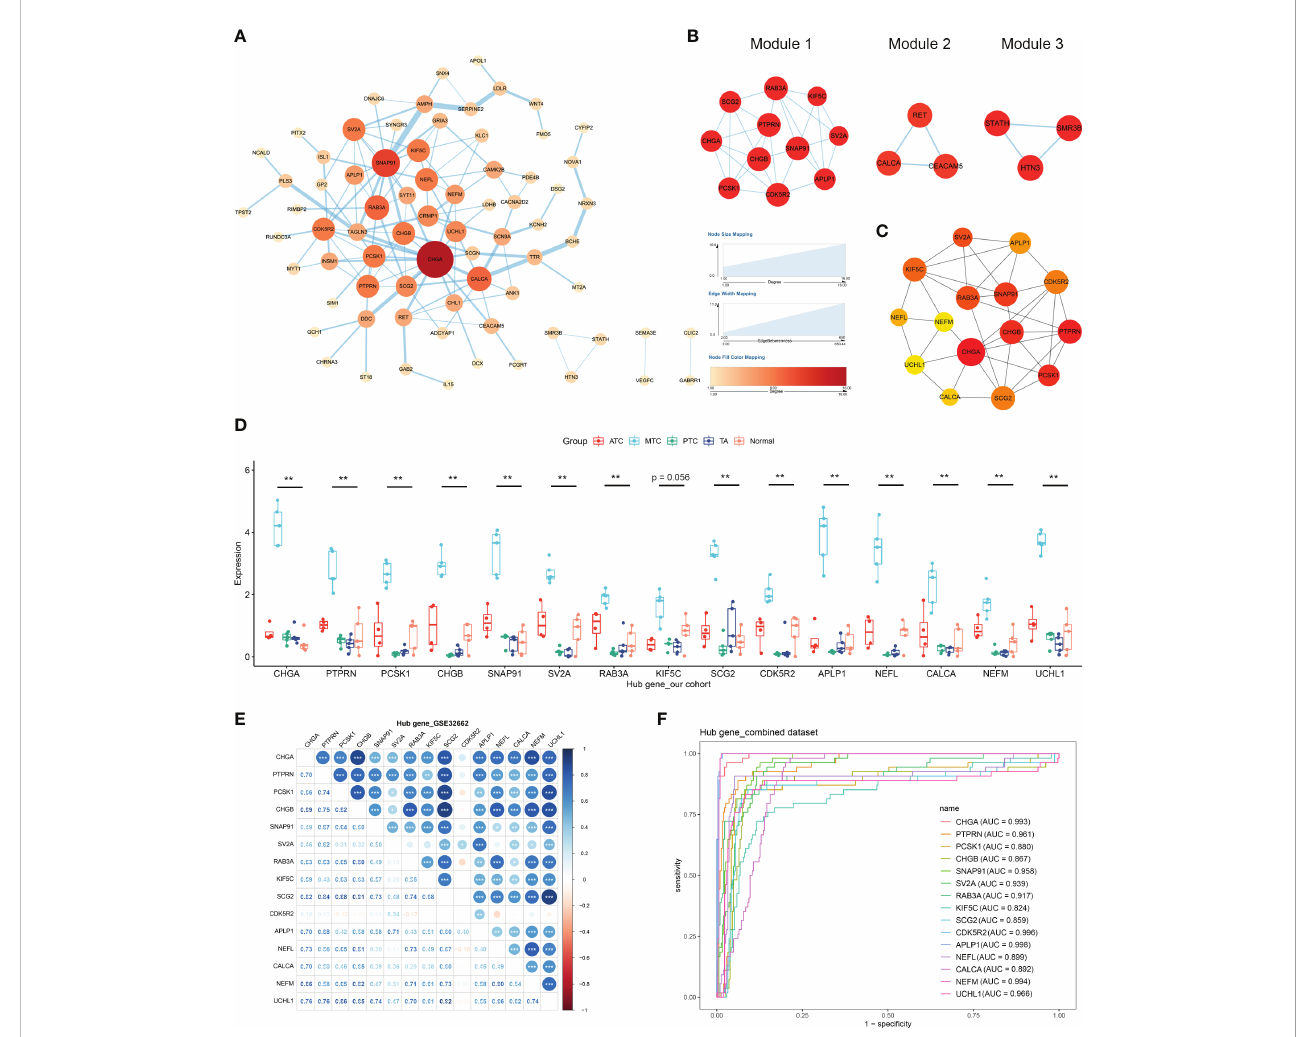
FIGURE 4 Protein – protein interaction (PPI) network construction and hub gene identi fi cation. (A) The PPI network of DEGs was constructed using the STRING database and visualized with Cytoscape. (B) Three modules identi fi ed by the MCODE algorithm. (C) The top 15 genes determined by the CytoHubba algorithm and ranked by the maximal clique centrality (MCC) method. (D) mRNA levels of hub genes by RT-qPCR in our cohort. (E) The correlations between hub genes by spearman analysis. (F) The receiver operating characteristic curve of hub genes. *p < 0.05; **p <0.01; ***p <